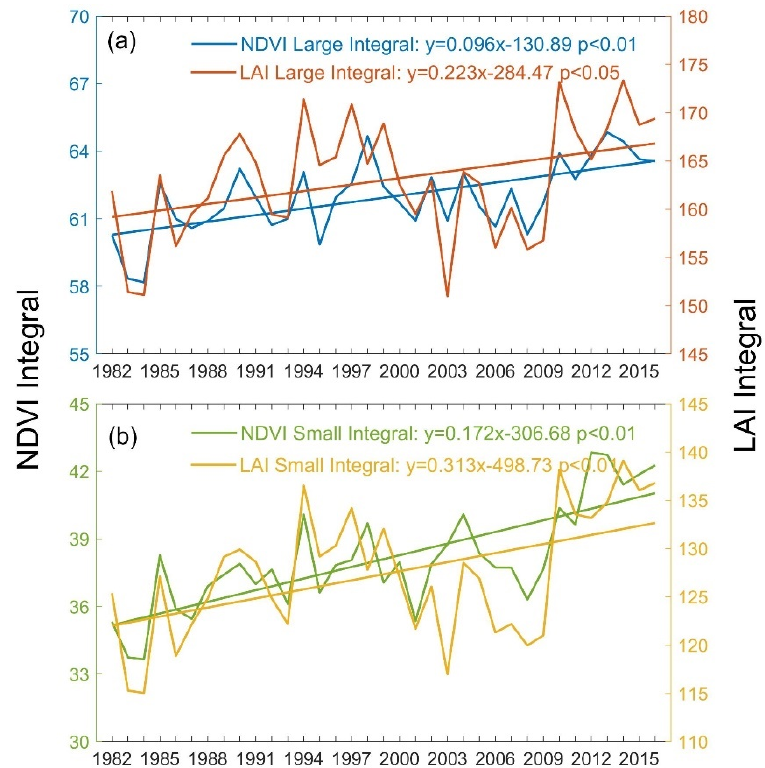
Figure 3. Variations of NDVI/LAI (large/small) integrals in Inner Mongolia from 1982 to 2016. ( a ) NDVI/LAI large integrals; ( b ) NDVI/LAI small integrals.